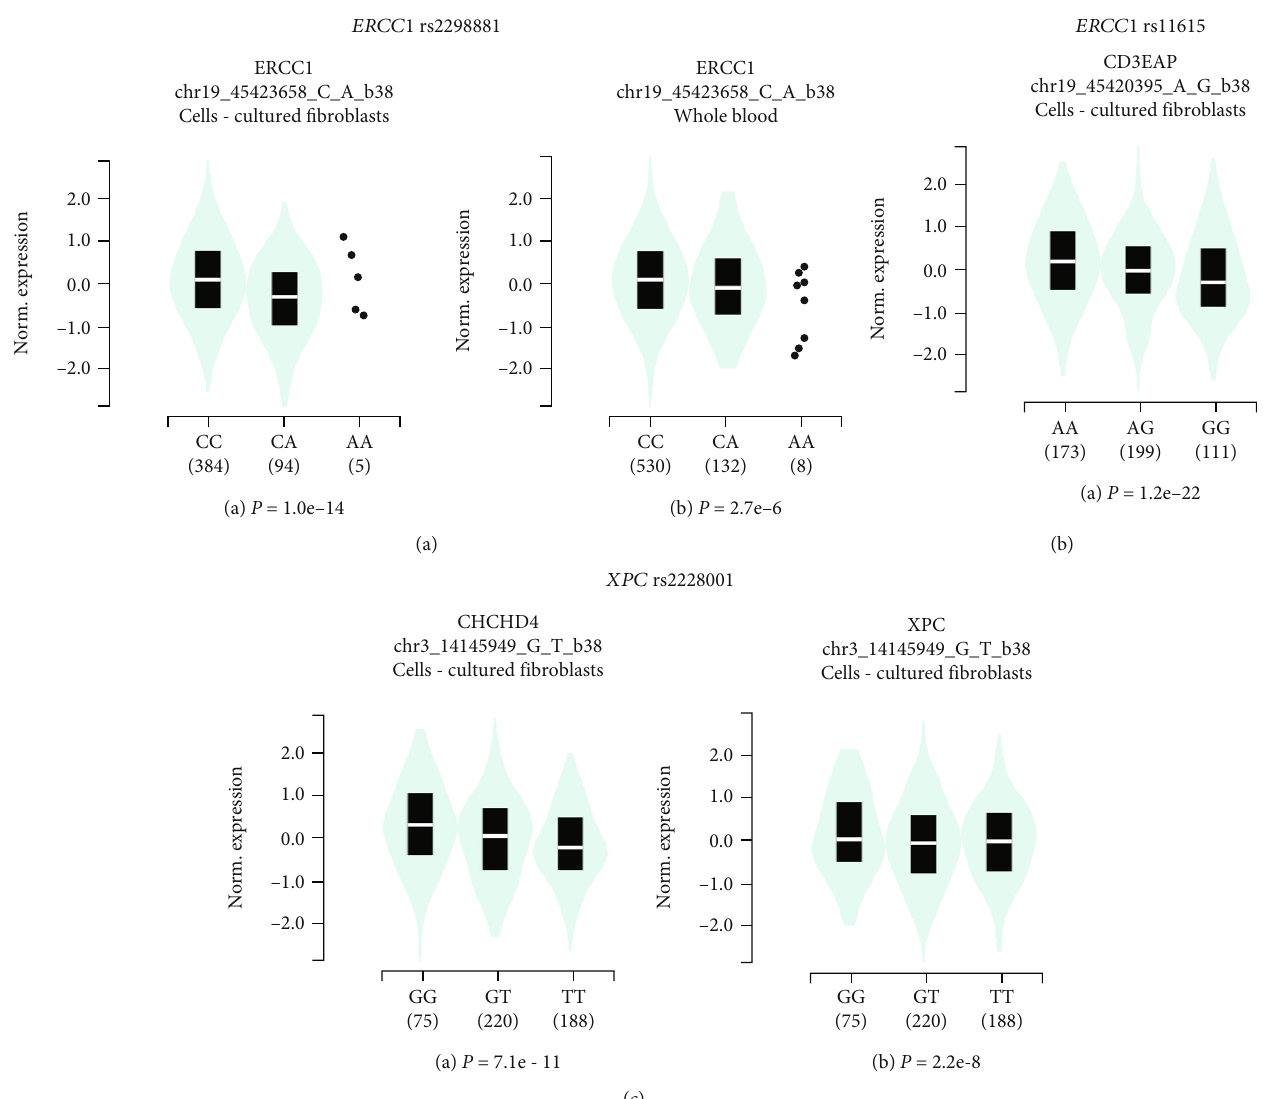
Figure 1: Expression quantitative trait loci (eQTL) analysis of the allergic rhinitis risk factors ERCC1 rs2298881 C > A , ERCC1 rs11615 G > A , and XPC rs2228001 A > C . (A) ERCC1 rs2298881 C > A genotype-based mRNA expression alteration of ERCC1 gene in the cells- cultured fi broblasts (a) and whole blood (b); (B) ERCC1 rs11615 G > A genotype-based mRNA expression change of CD3EAP gene in the cell-cultured fi broblasts; (C) XPC rs2228001 A > C genotype-based mRNA expression change of CHCHD4 (a) and XPC (b) genes in the cells-cultured fi